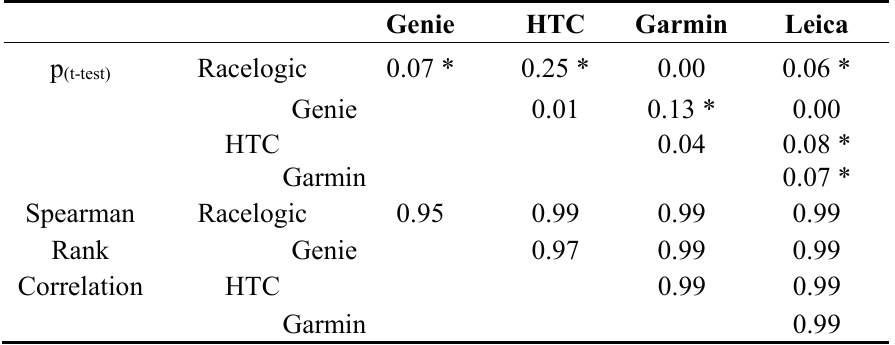
Table 6. Significance of pairwise sample t-test (p (t-test) ) and Spearman rank correlations between GNSS systems maintaining speed of 50 km/h Genie HTC Garmin